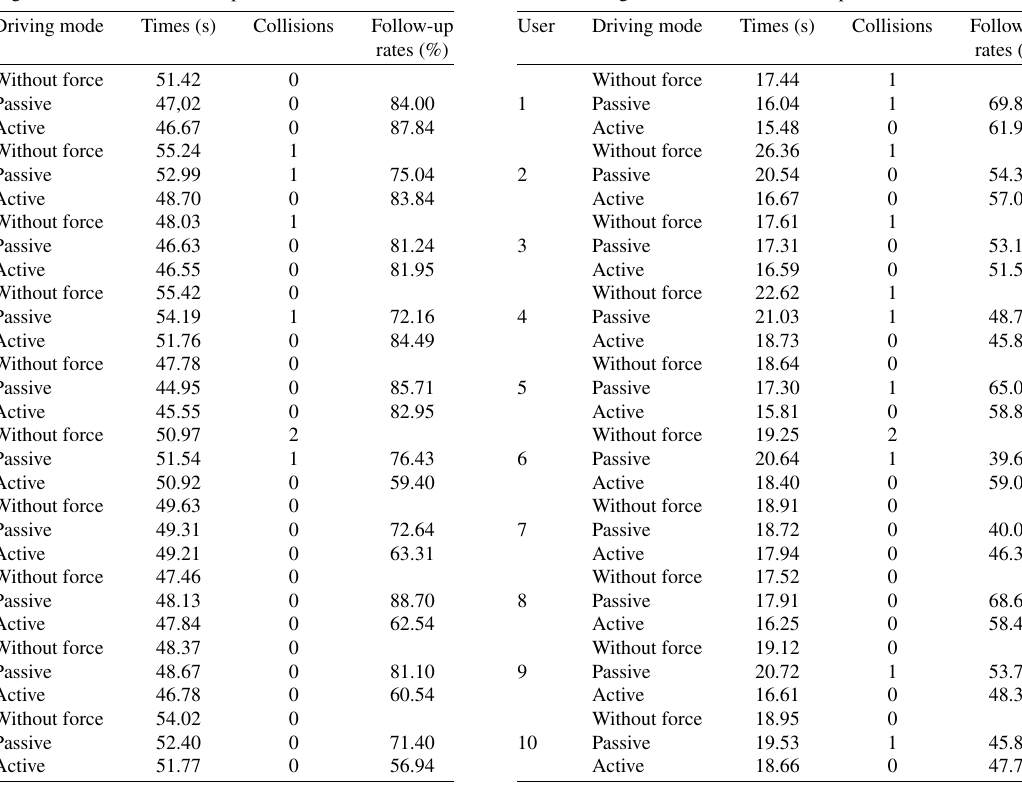
Table 2 Time averages, collisions and follow-up rates for the second zone